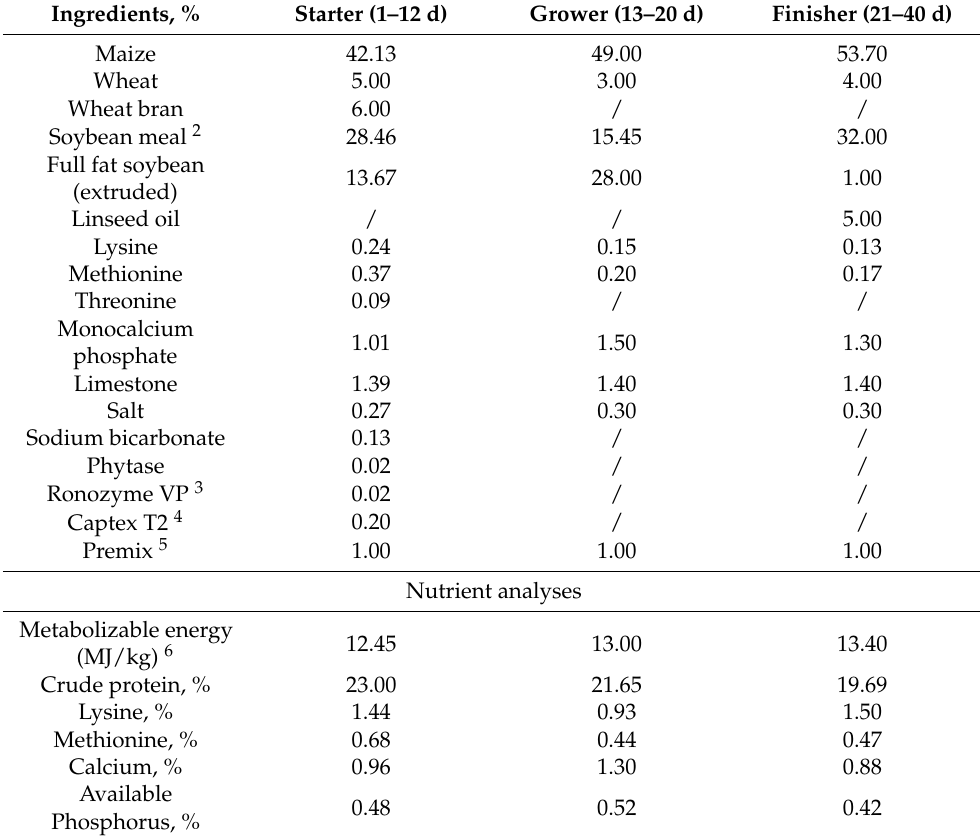
Table 1. Composition and nutrient content of the starter, grower and finisher diets 1